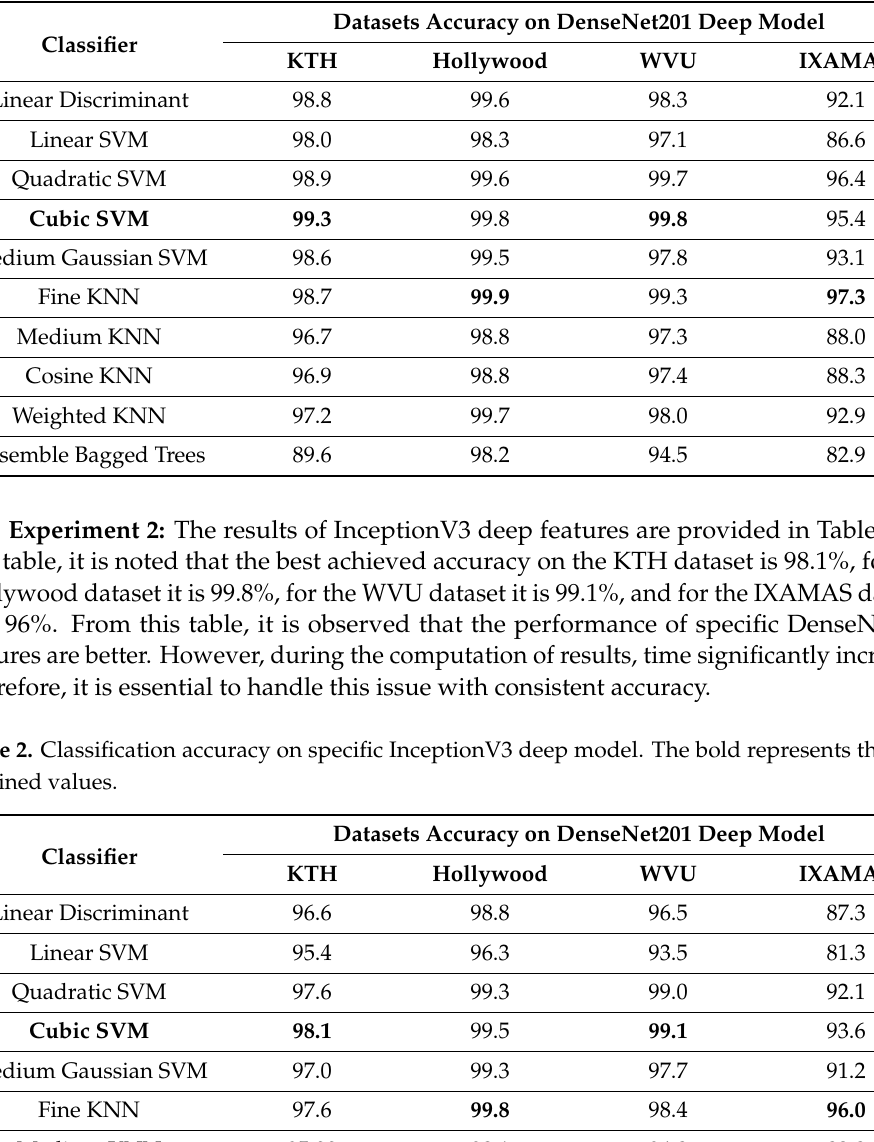
Experiment 3: After the experiments on specific feature sets, the SbE approach